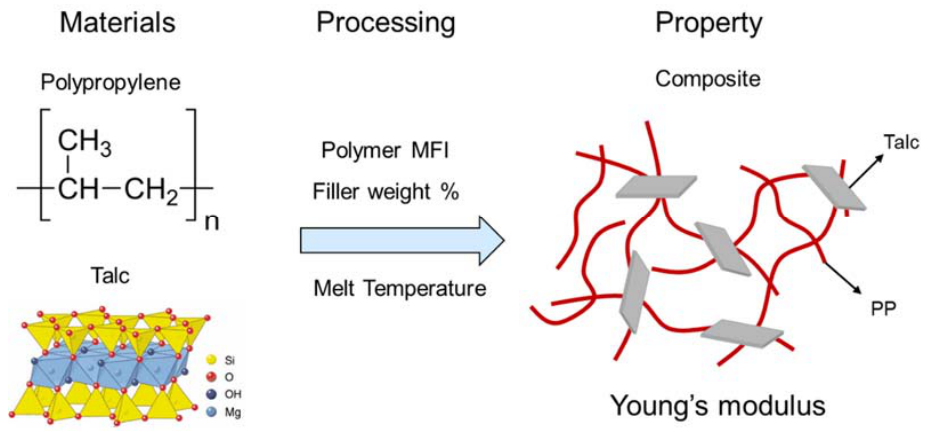
Figure 3. Proposed polymer and filler to develop high strength composites and a key property of interest: Young’s modulus.